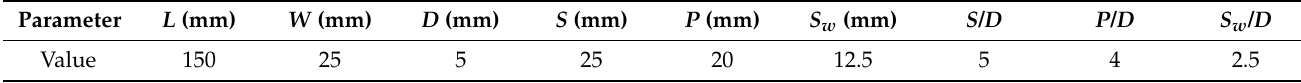
Figure 4. Schematics of notched Glare specimens with different hole arrangements. Table 5. Dimensions of notched Glare specimens in present investigation.